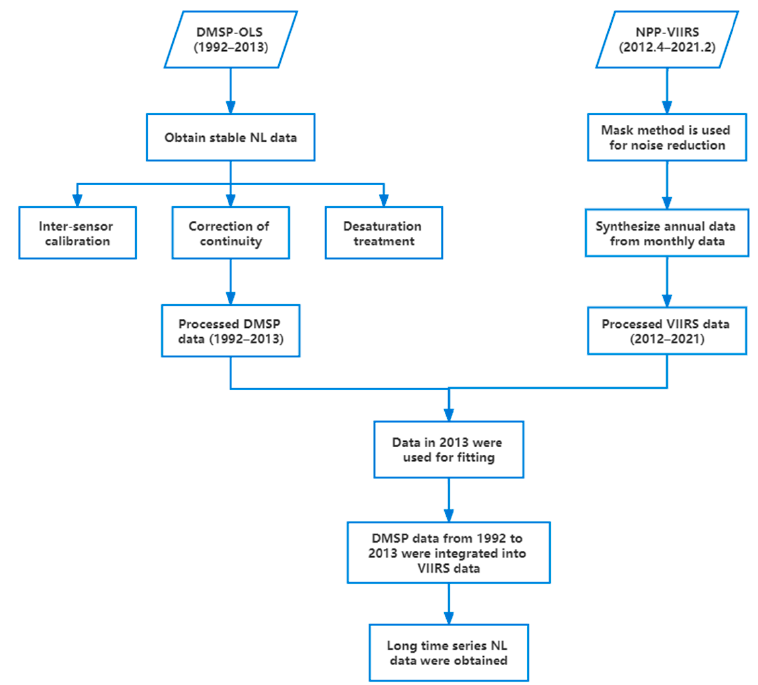
Figure 1. The process of data fitting.